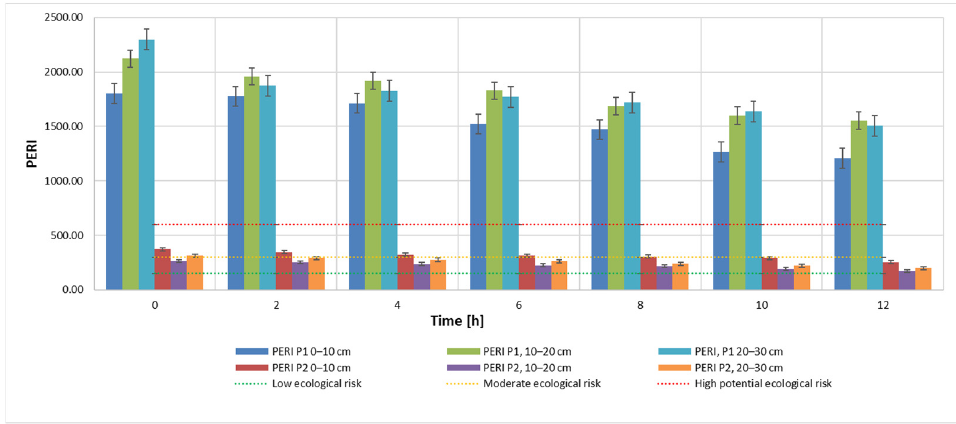
Figure 6. PERI—potential ecological risk index during the extraction process according to admissibility limits and sampling depth using 20 mL 9K medium.